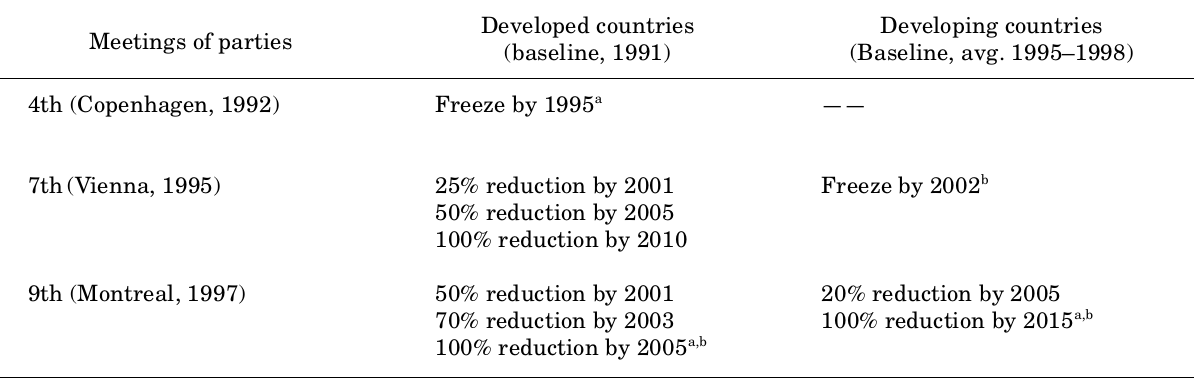
Table 1. Control measures on methyl bromide production and consumption adopted by the meetings of the parties to the Montreal Protocol (Gullino et al ., 2003).